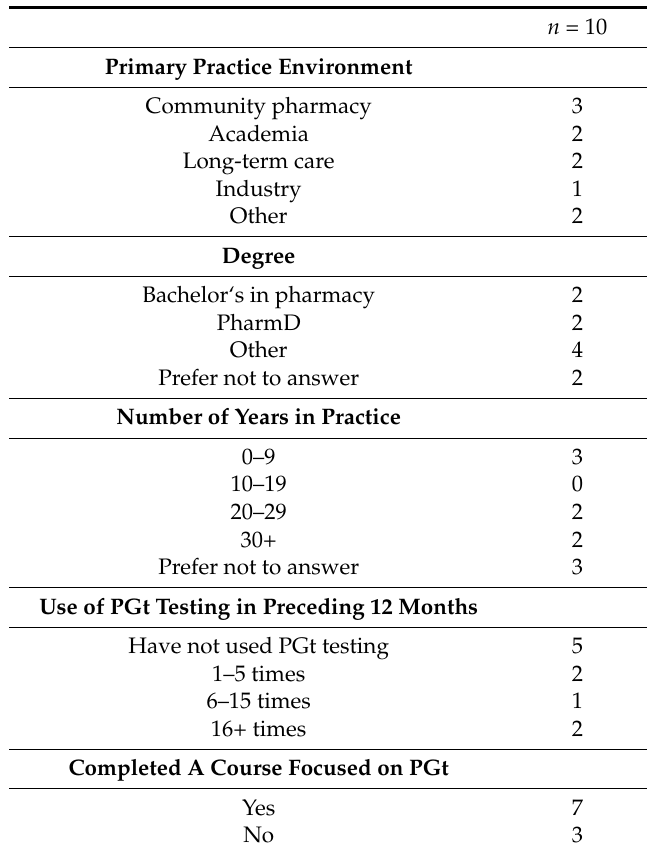
Table 1. Pharmacist respondent